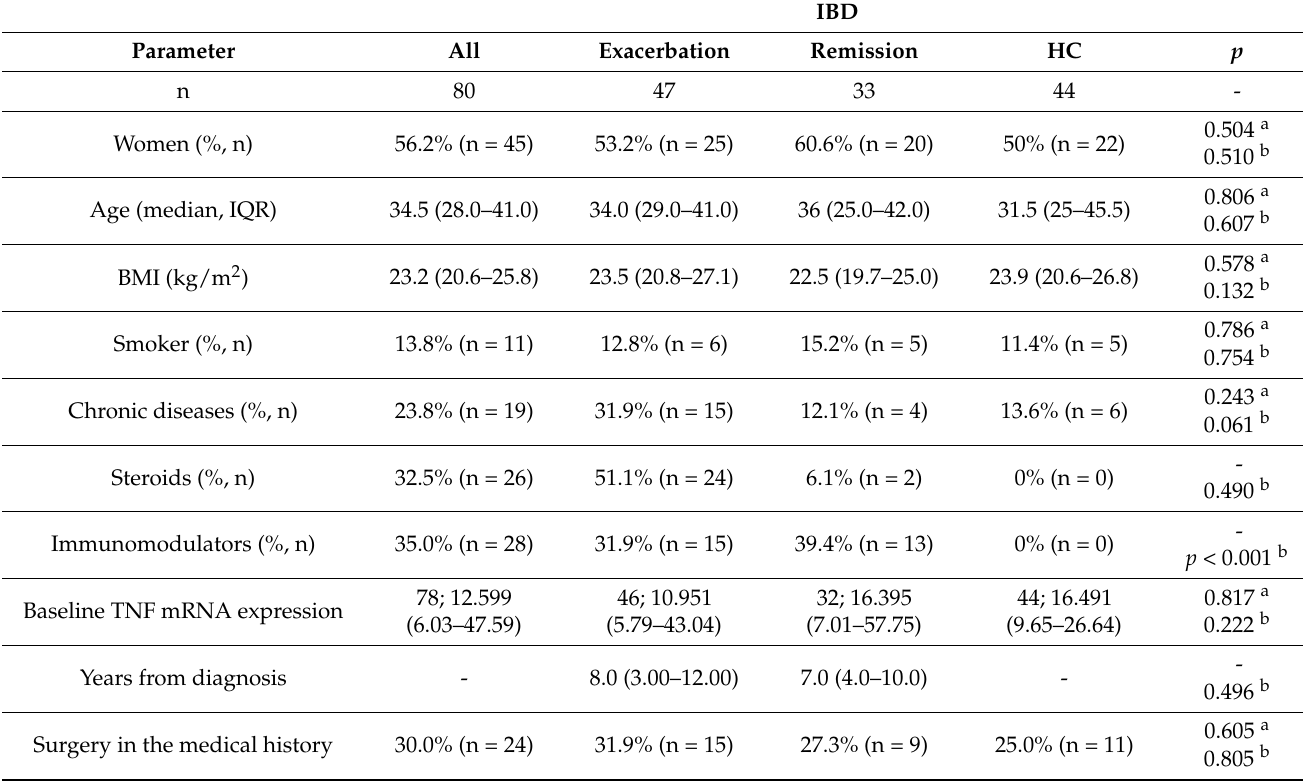
Table 1. Study participants’ characteristics.